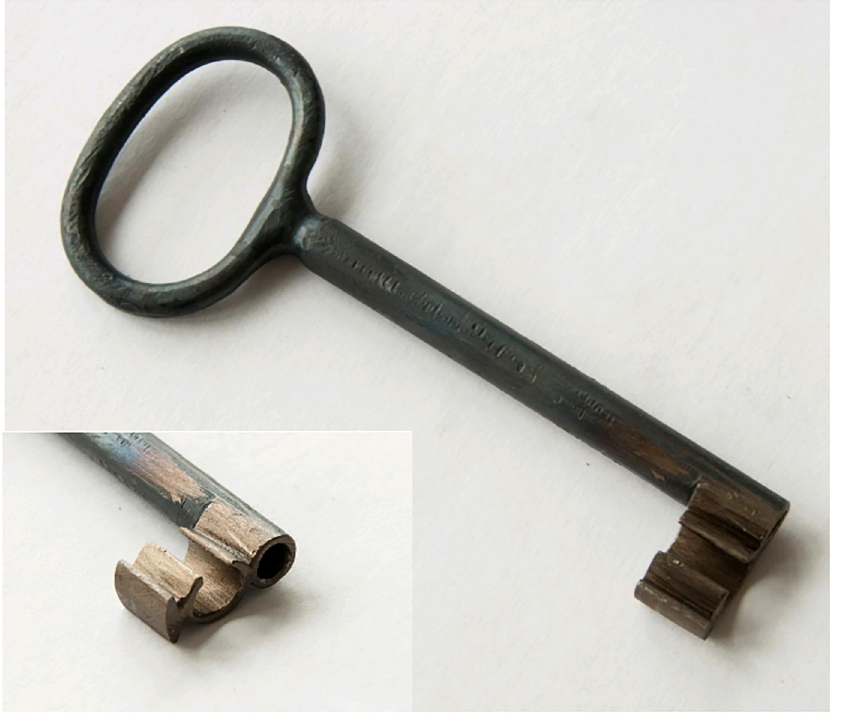
Fig 7. Second manufactured key copy; the key bit is pictured in two different